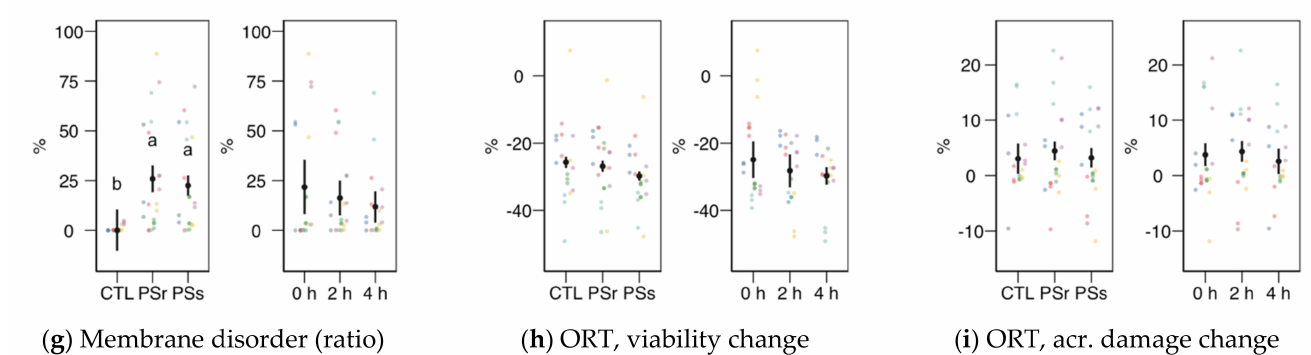
Figure 3. Sperm physiological variables obtained by flow cytometry (mean ± CI95% with individual observations as dots, n = 6) during the incubation (4 h at 37 ◦ C) of thawed boar spermatozoa with seminal plasma from boars whose spermatozoa were resistant or sensitive to the cold-shock (PSr and PSs) or incubated with just MR-A (control, CTL). ( a ) Viable spermatozoa as PI − events. ( b ) Acrosome-reacted (damaged, PNA + ) spermatozoa. ( c ) Spermatozoa with damaged acrosome as the ratio of viable spermatozoa (PI − ). ( d ) Apoptotic spermatozoa (YO-PRO-1 + ) as the ratio of viable (PI − ). ( e ) Spermatozoa with active mitochondria (Mitotracker + ). ( f ) Spermatozoa with active mitochondria as the ratio of viable spermatozoa (YO-PRO- 1 − ). ( g ) Spermatozoa with high membrane disorder (M540+), as the ratio of viable spermatozoa (YO-PRO-1 − ). ( h ) Change of viable spermatozoa as PI − after the osmotic resistance test (ORT). ( i ) Change of acrosome-reacted (damaged, PNA + ) spermatozoa after ORT. Since no interactions were significant, we show the results of the seminal plasma and incubation treatments separately as main effects. Different letters show significant differences among treatments or times ( p <